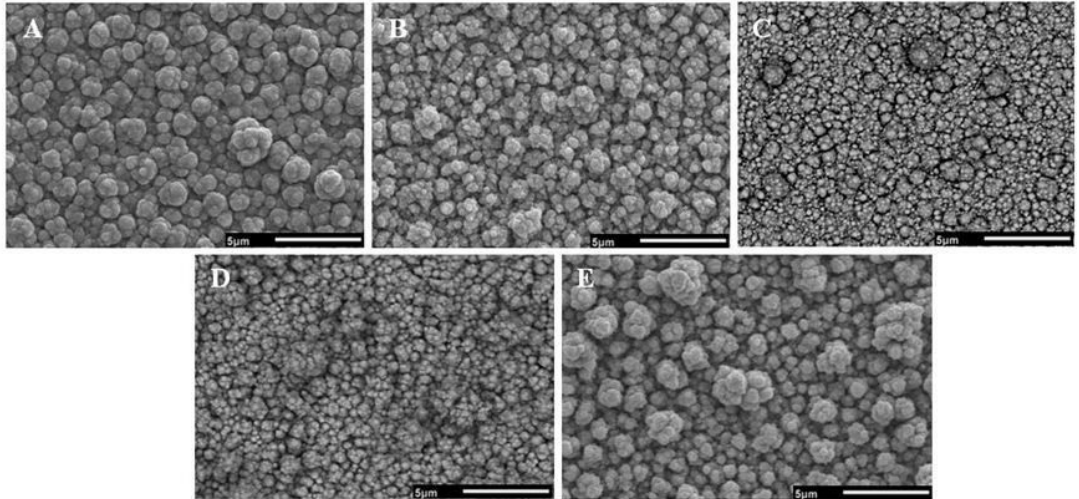
= 167.0 A m -2 (Experiment 2’); c = 504.1 A m -2 (Experiment 5’) (E) j = 667.0 A m -2 c c